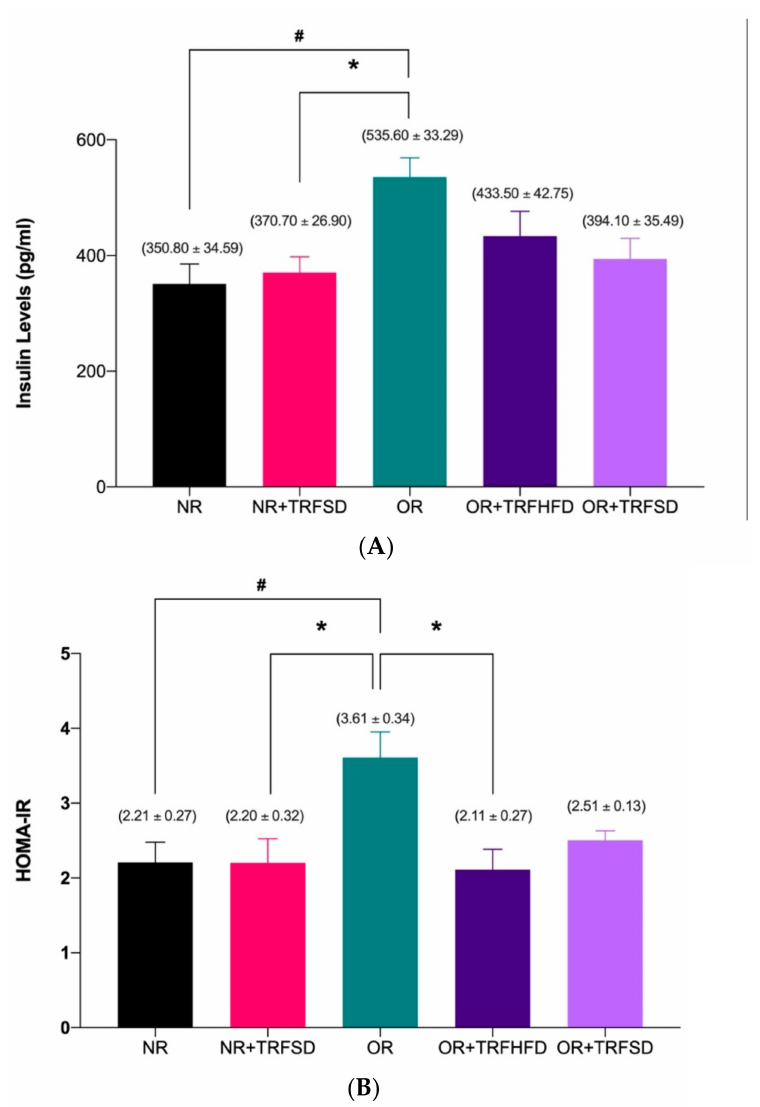
Figure 1. Effect of time-restricted feeding on serum insulin level ( A ) and HOMA-IR ( B ) in the normal and obese groups. Data are presented as mean ± SEM ( n = 7). # p < 0.05 vs. NR. * p < 0.05 vs.